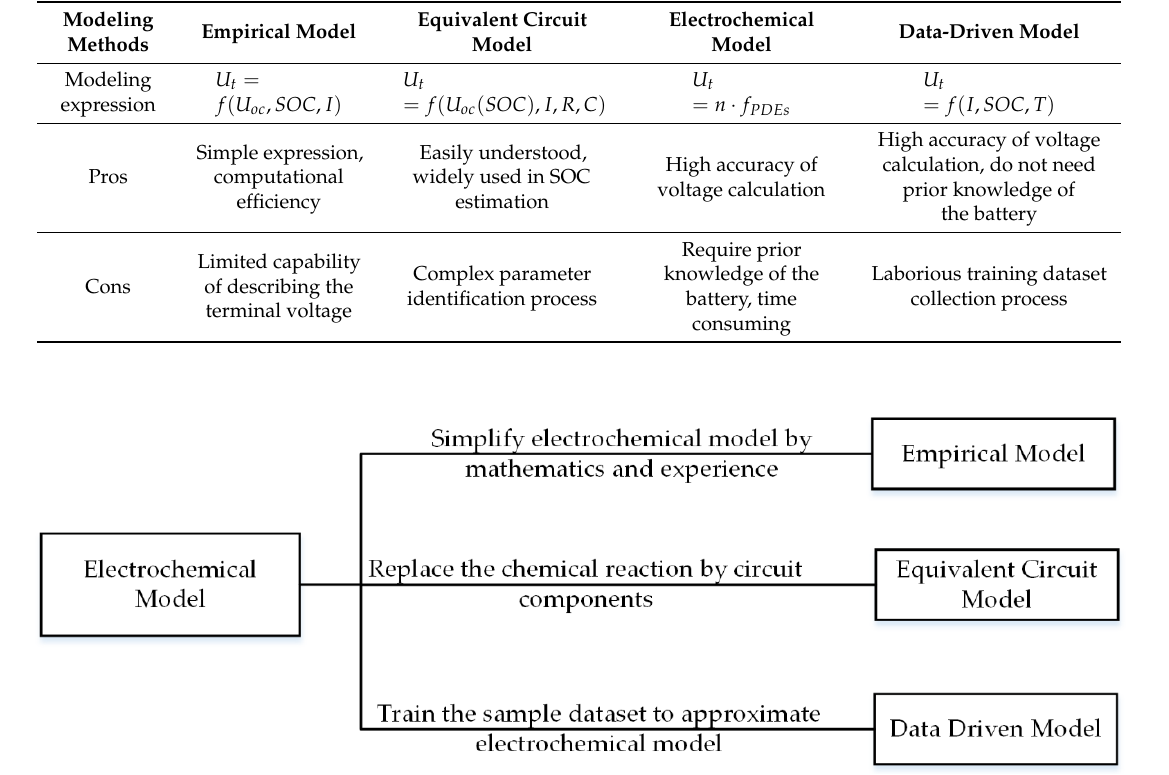
Figure 5. The connections of different modeling methods.